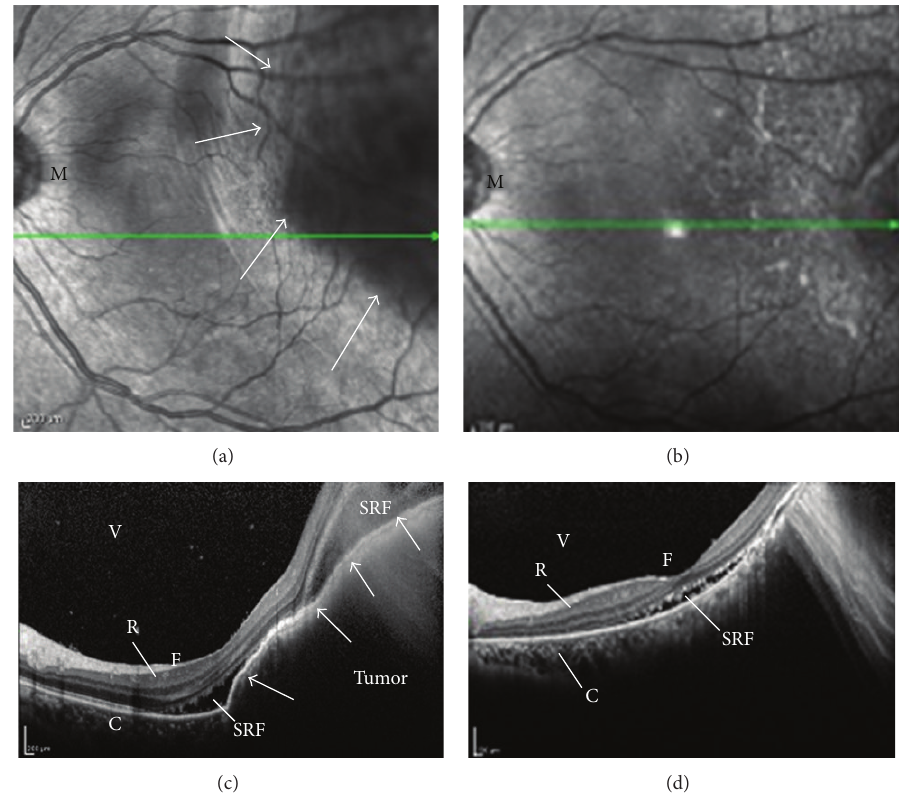
Figure 1: (a) Photograph of fundoscopy in the involved eye (left-side) before gefitinib treatment. A large elevated lesion in the superotemporal quadrantwasfound(arrows)withexudation.Thepatient’sbestcorrectedvisualacuityinthelefteyewas20/200beforetreatment.(M:macula). (b) The elevated lesion disappeared a month after the onset of gefitinib treatment. Her best corrected visual acuity in the left eye improved to 20/100 after treatment. (c) Optical coherence tomography (OCT) before treatment corresponding to (a). A dome-shaped large mass with high reflectivity occupied the choroid, pushing the retina into the vitreous-cavity side (arrows). Accumulation of the subretinal fluid was also observed. (C: choroid, F: fovea centralis, R: retina, SRF: subretinal fluid, V: vitreous body). (d) Complete flattening of the tumor and decreased subretinal fluid were observed, demonstrating a dramatic response to